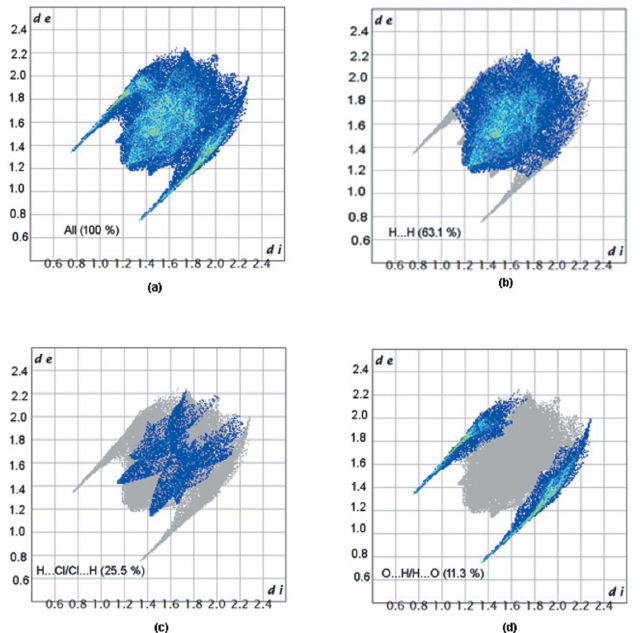
Figure 6 View of the two-dimensional fingerprint plots for the title compound showing ( a ) all interactions, and those delineated into ( b ) H (cid:2)(cid:2)(cid:2) H (63.1%), ( c ) H (cid:2)(cid:2)(cid:2) Cl/Cl (cid:2)(cid:2)(cid:2) H (25.5%) and ( d ) O (cid:2)(cid:2)(cid:2) H/H (cid:2)(cid:2)(cid:2) O (11.3%)